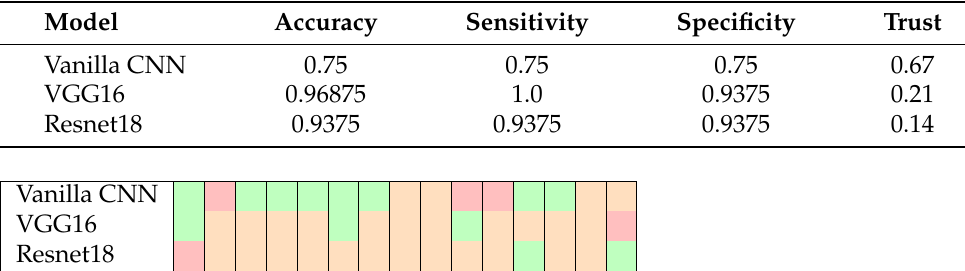
Figure 6. Visualizing results: each cell represents an image of the test set that was predicted using a model. Green cells represent correct and trustworthy predictions (i.e., those where the lesions were relevant for the model output); orange cells are those where the model predicted the right label, but the prediction might not be trustworthy; and red cells are prediction